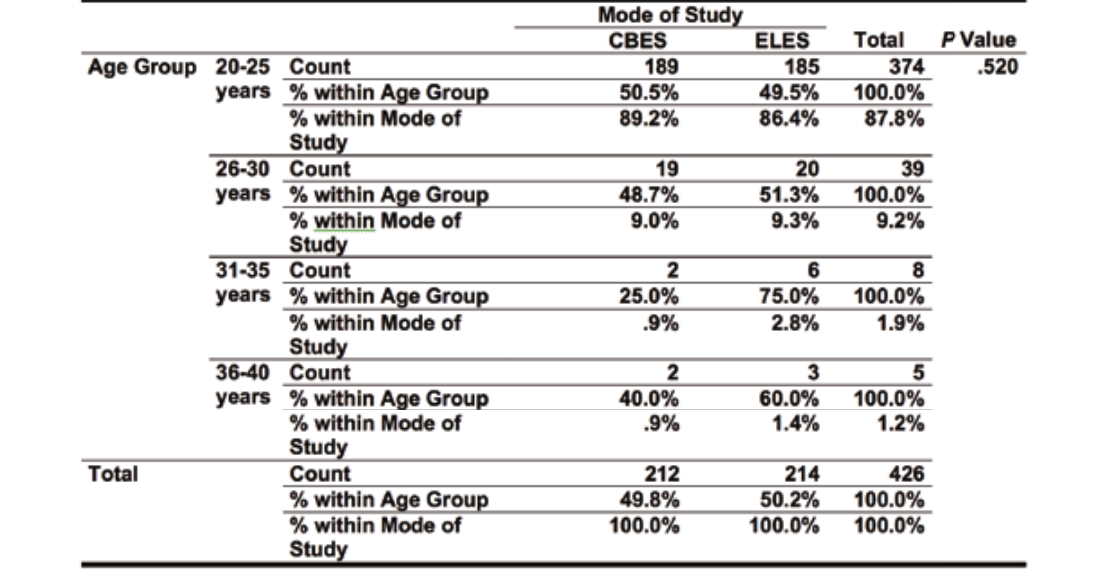
Table 3: Comparison of Age between the two